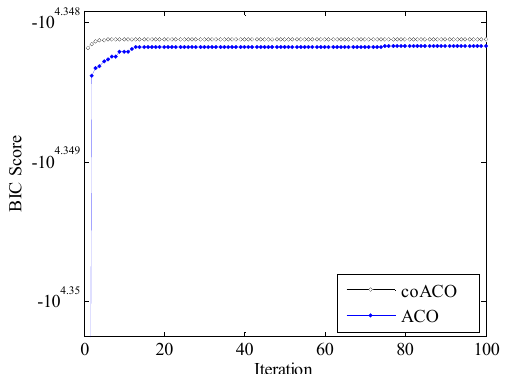
Figure 8. Evolution curves of the average BIC score achieved by ACO and coACO on the ASIA dataset with n = 10,000.